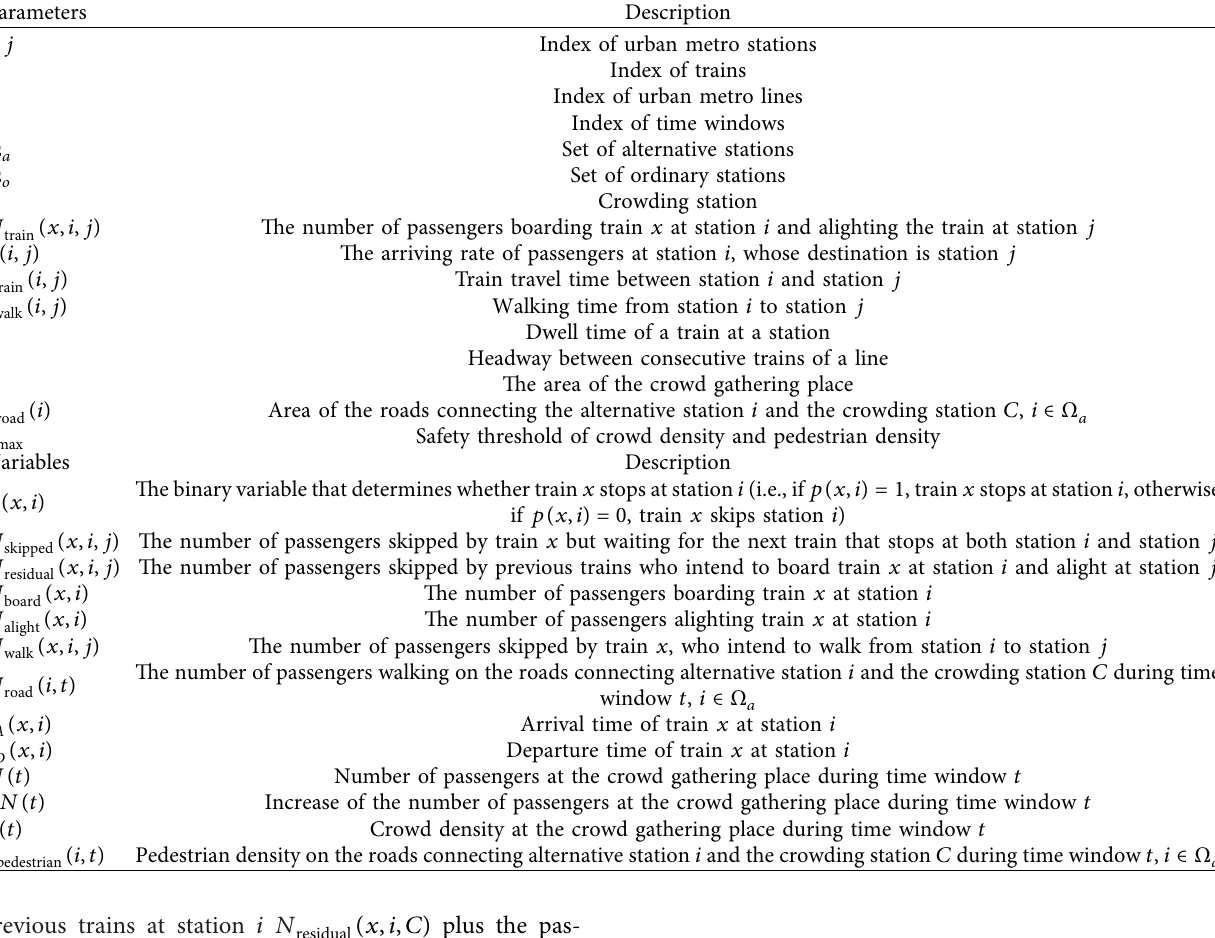
Table 1: Parameter and variable